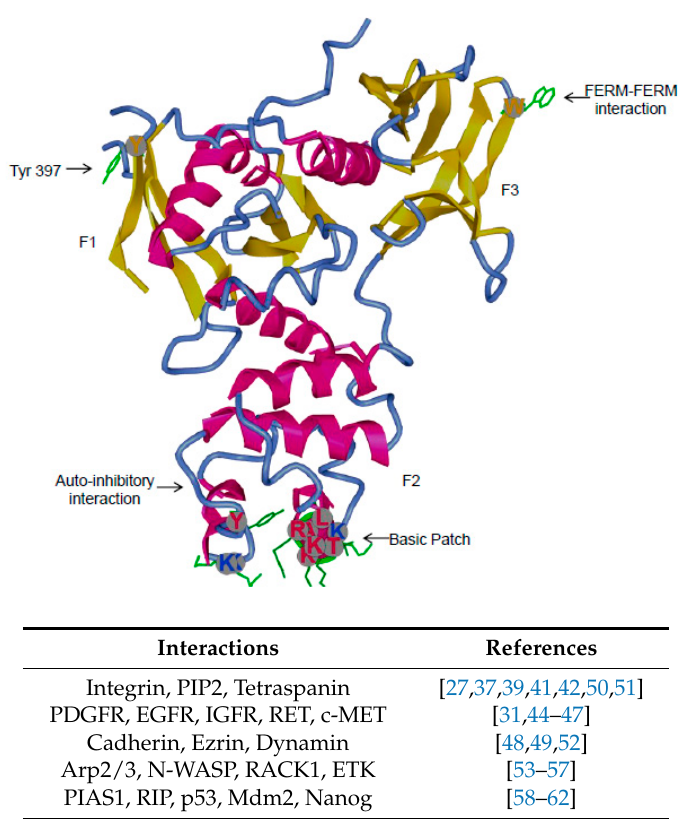
Figure 2. Structure of the FERM domain of FAK from the protein databank (accession code 2AL6). The FERM domain displays three lobes, F1, F2 and F3. The structure includes the Tyr397 auto-phosphorylation site which is located between the FERM and kinase domain. In the F2 lobe, residues belonging to basic patches important for FAK activation are highlighted and their side chains coloured in green. The auto-inhibitory interaction implicates residues from the F2 lobe of the FERM domain and C lobe from the kinase domain. The Trp266 implicated in FERM-FERM interaction necessary for FAK dimerization is also highlighted. Proteins associating with the FERM domain are shown in the